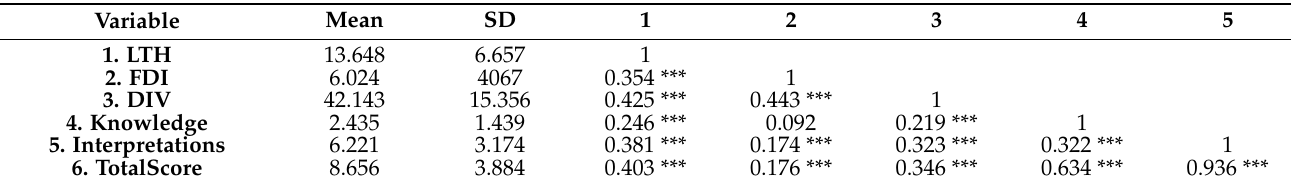
Table 1. Correlation